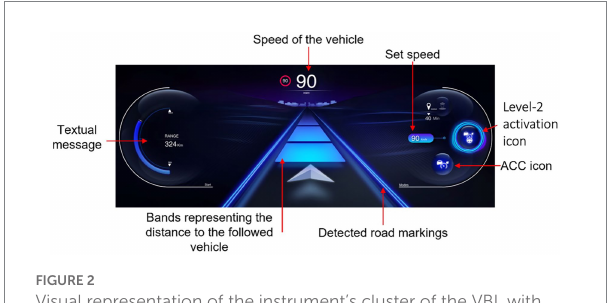
FIGURE 2 Visual representation of the instrument’s cluster of the VBI, with information that was mutual to both interfaces. The driving speed is 90 km/h. The message box on the left gives information on the remaining kilometers on the fuel tank. On the right side, the status of activation of driving automation systems and the set speed are displayed. In the center of the screen, the detected road markings and set distance of the ACC are displayed (blue). Adapted/ Reproduced with permission from IRT